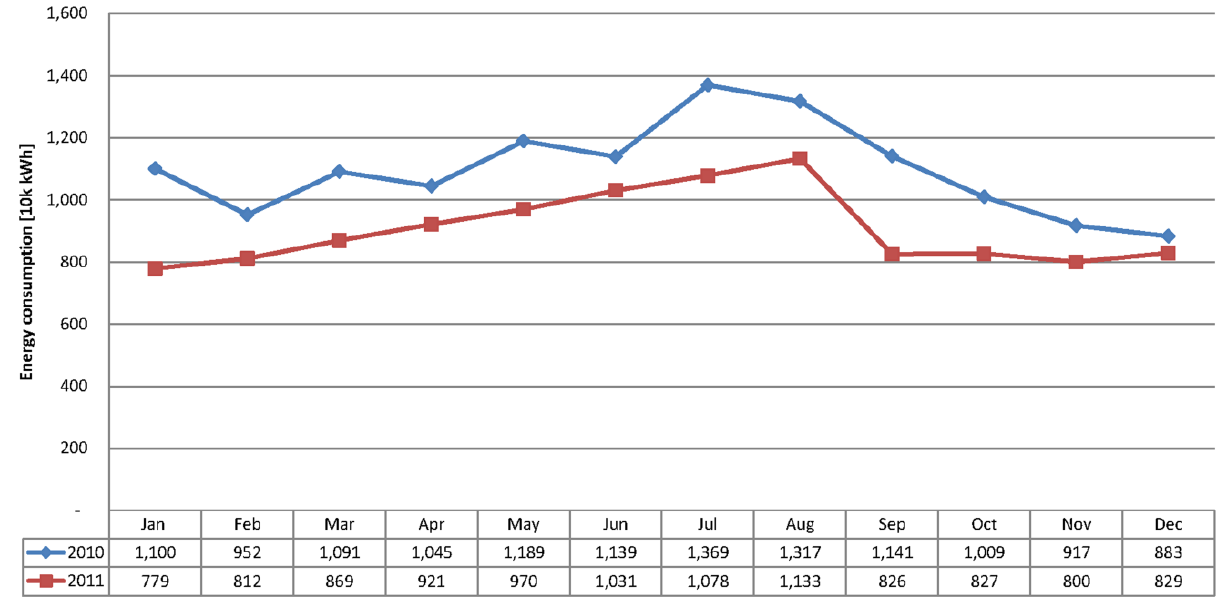
Figure 6. Comparison of energy consumption before and after implementing the ISO 50001 in 2010–2011.